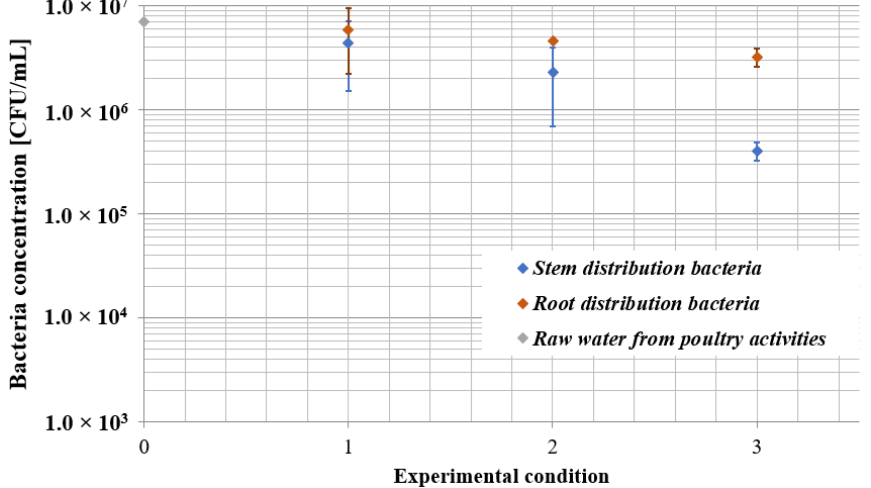
Figure 6. Internalization of E. coli bacteria in lentil structures. Experimental conditions: (0) raw wastewater from poultry activities, (1) without treatment application, (2) direct application of NTP to plants irrigated previously with wastewater from poultry activities, and (3) activation of raw wastewater used for irrigation of seeds.